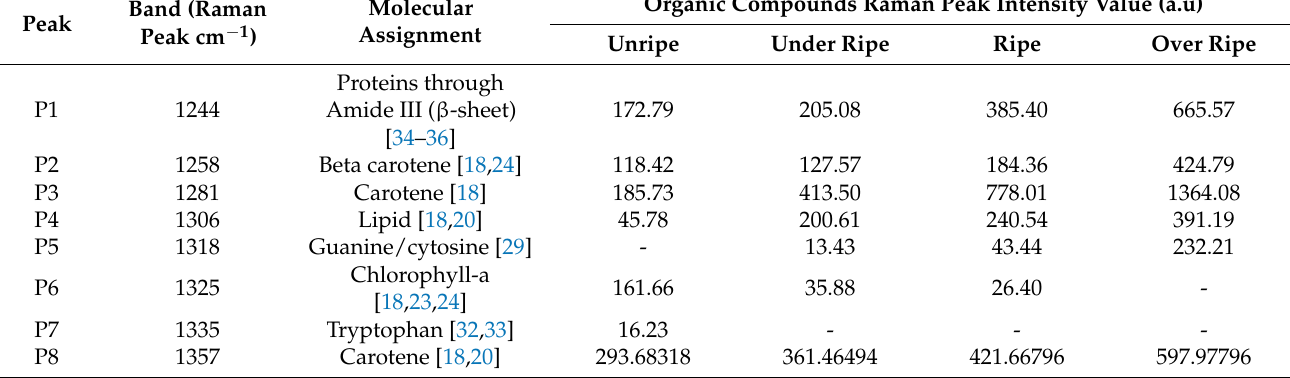
Table 4. Summary of Raman bands and their molecular assignments with intensity values for four oil palm fruit ripening classes for sample A in the range of 1240 cm − 1 to 1360 cm − 1 after spectrum pre-processing and deconvolution.